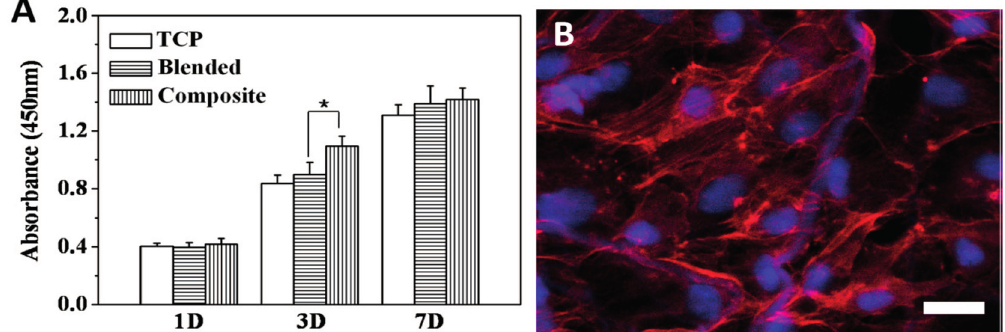
Figure 11. ( A ) Cell viability after seeding measured for 1, 3 and 7 days; ( B ) Confocal image of endothelial cells on the composite scaffolds for day 7. Scale bar = 25 μ m. Reprinted with permission from [124], Copyright © 2012 Elsevier Science B.V.